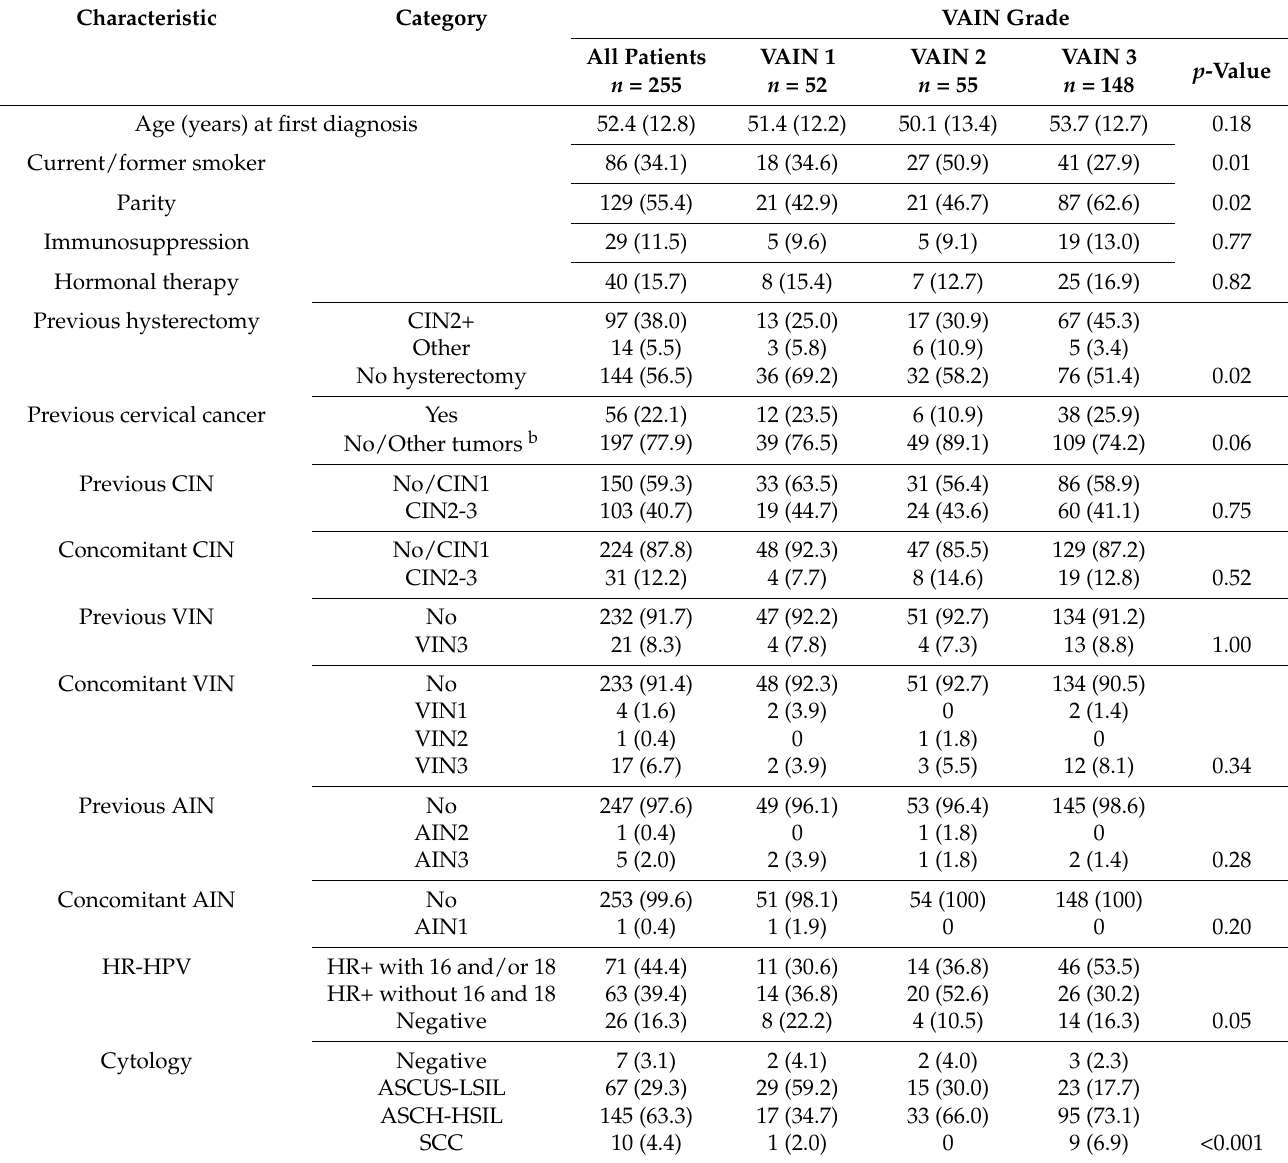
Table 1. Patients’ characteristics summary statistics a by VAIN grade at